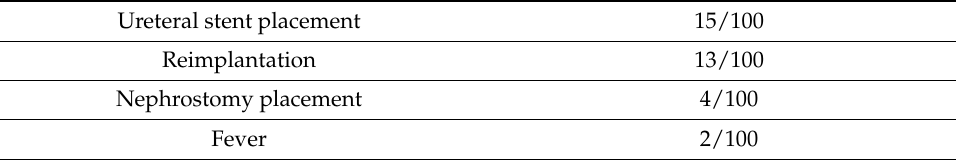
Table 3. Reasons for